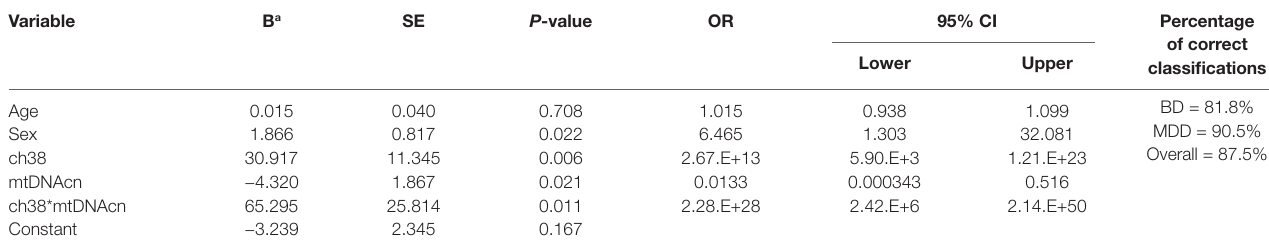
TABLE 3 | Multivariate logistic regression analysis of bipolar disorder (BD)/major depressive disorder (MDD) with ch38 and mitochondrial DNA copy number (mtDNAcn).